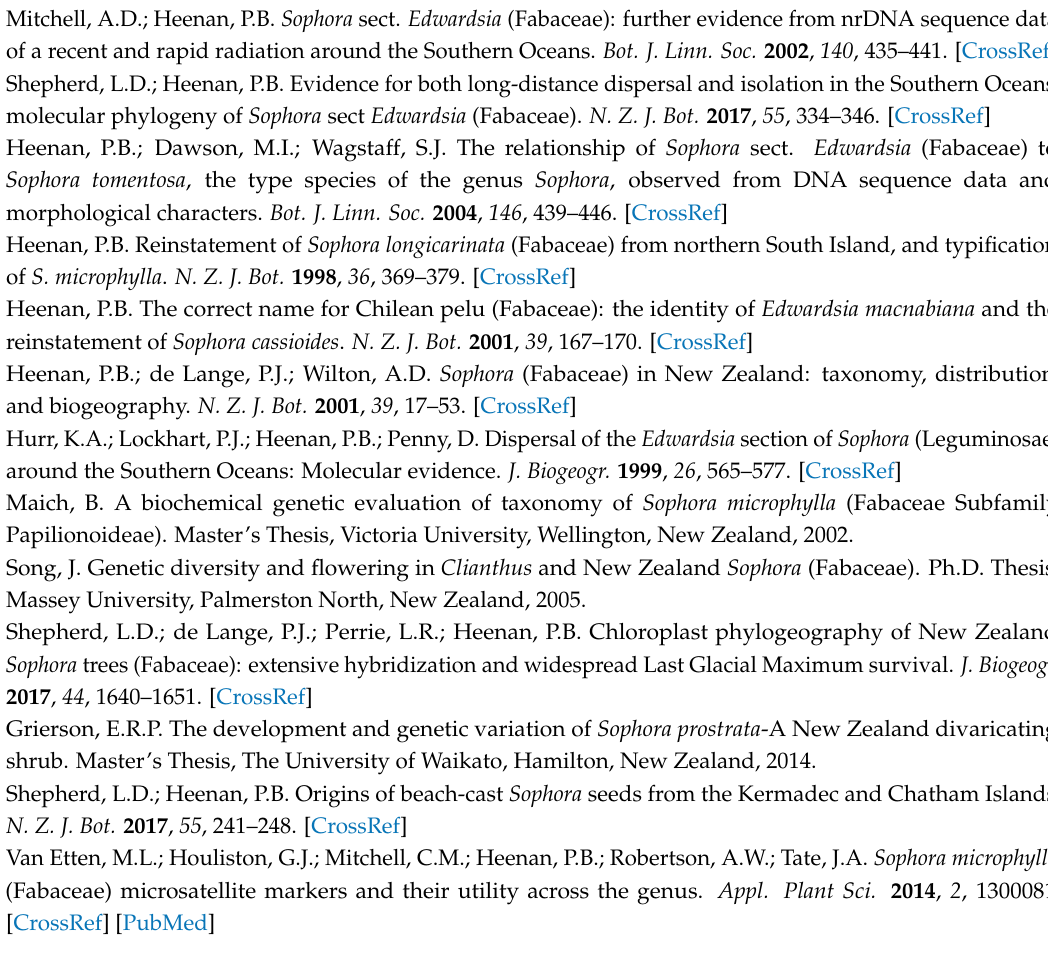
Table S1: Samples used for the